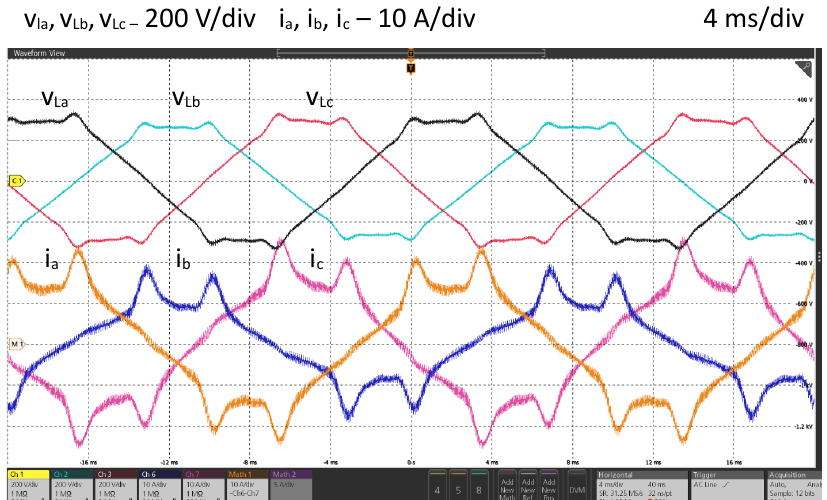
Figure 14. Experimental results of a steady state for the system without repetitive